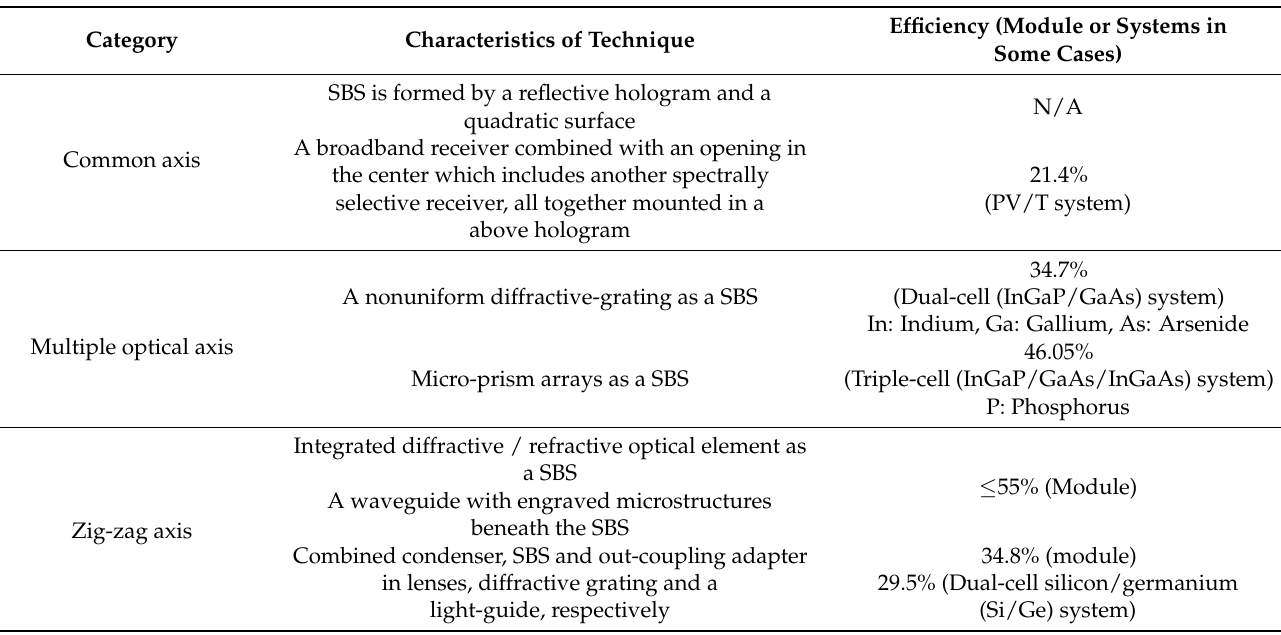
Efficiency (Module or Systems in Some Cases) N/A